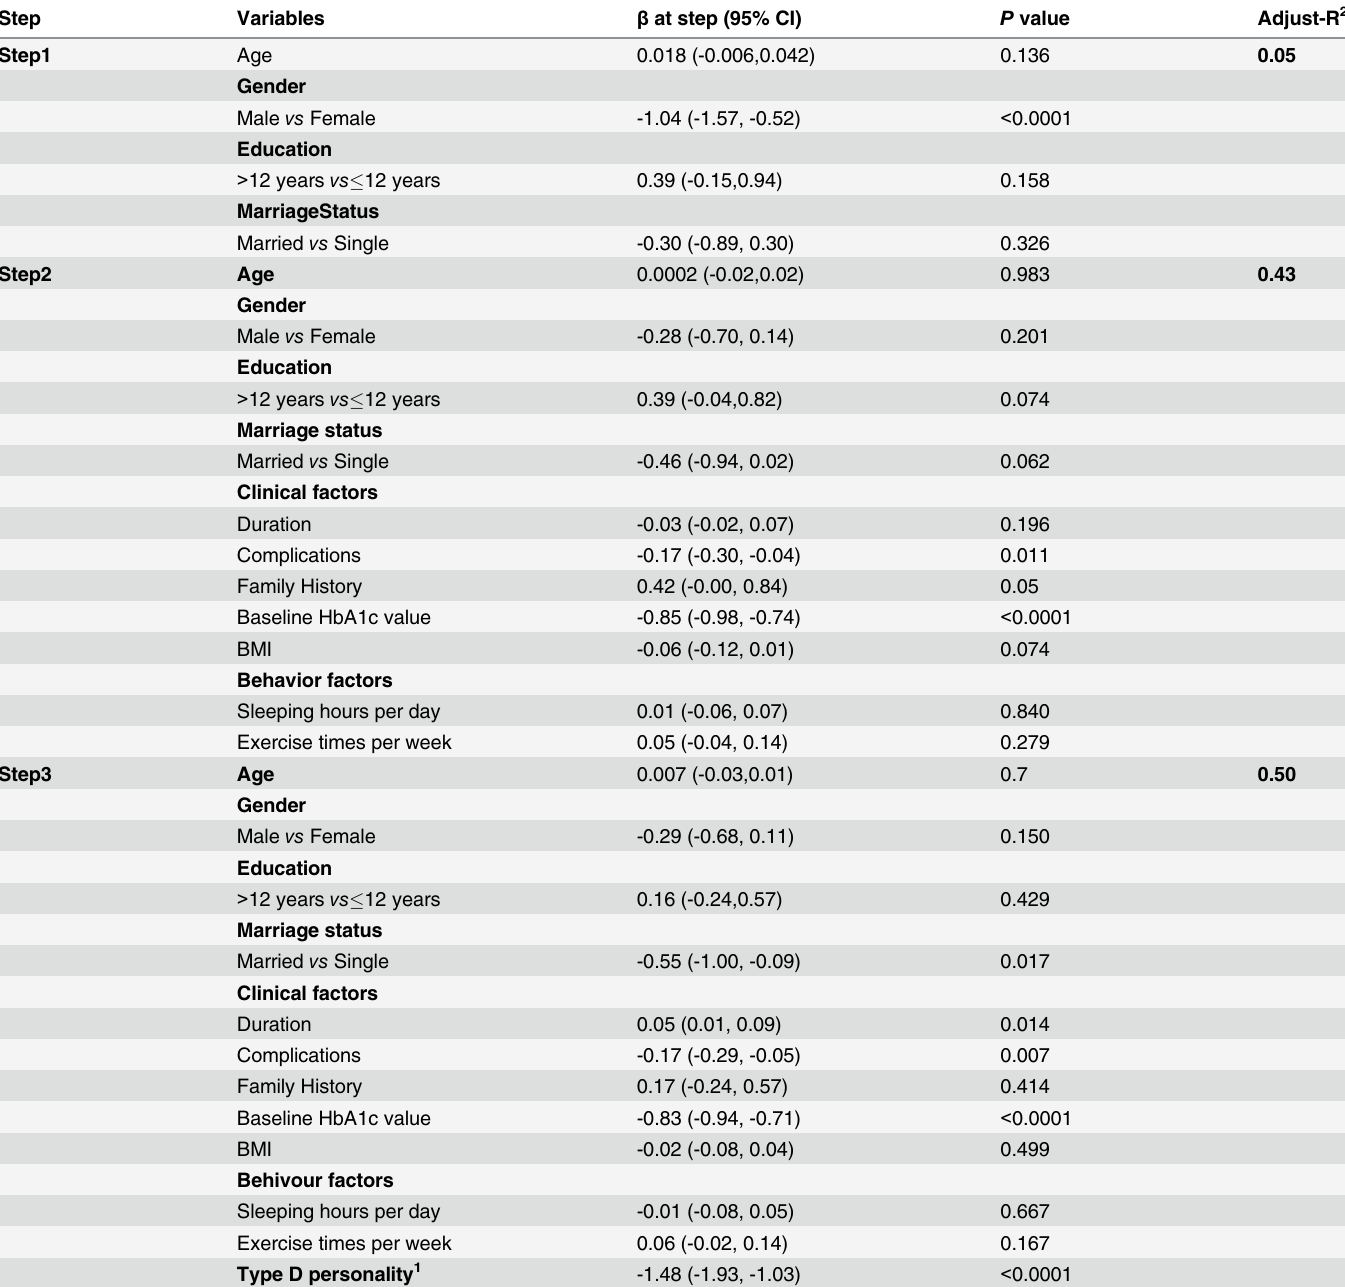
Table 3. Hierarchical regression analyses predicting medication adherence at